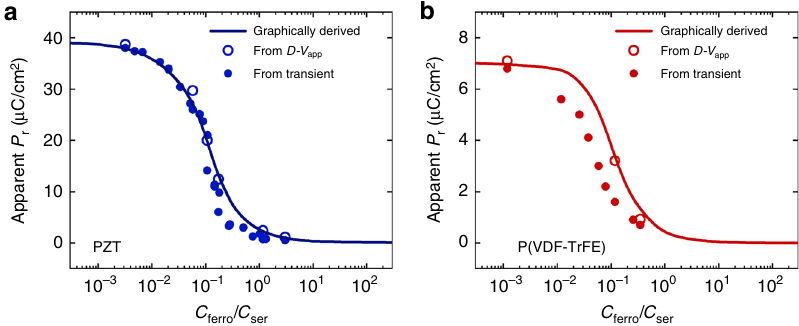
Fig. 2 Suppression of polarization. Apparent remanent polarization, i.e. the displacement at zero applied voltage, as a function of the ratio of capacitances, C C fl uoride – tri fl uoroethylene) [P(VDF – TrFE)] in serial circuits. The open circles are extracted from ferro / ser , for a Pb(Zr,Ti)O 3 (PZT) and b poly(vinylidene Fig. 1b, e. Solid circles are obtained from transient measurements described in the next section. Solid lines present graphically extracted values as discussed in Supplementary Note